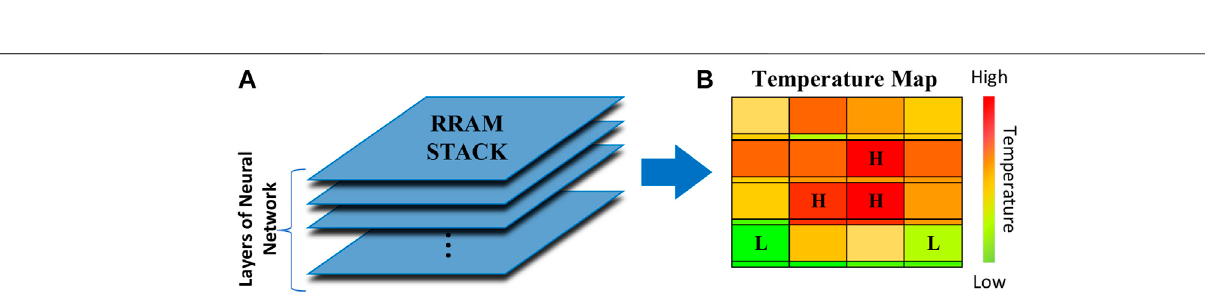
Frontiers in Sensors |